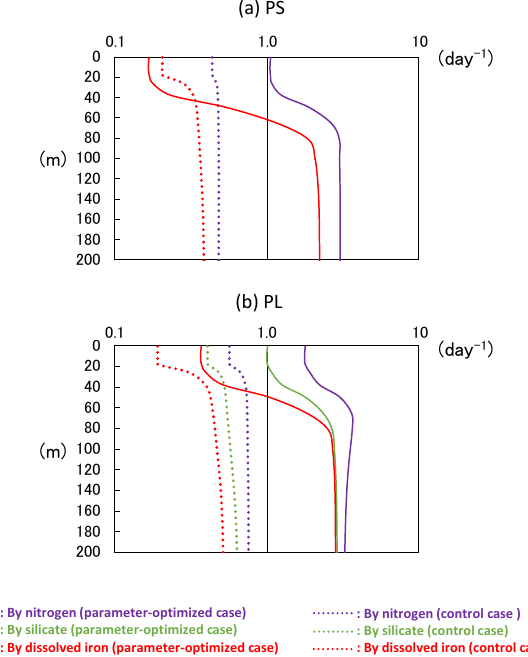
Figure 11. Vertical distributions of limited growth rates by nitrogen, silicate, and dissolved iron simulated from the 3-D model of (a) PS and (b) PL at KNOT on 20 July 1998. The smallest rate of dissolved iron most heavily limits the rate of phytoplankton’s photosynthesis. These limited growth rates (molNm − 3 day − 1 ) were divided by the PS or PL biomass (molNm − 3 ) to standardize.